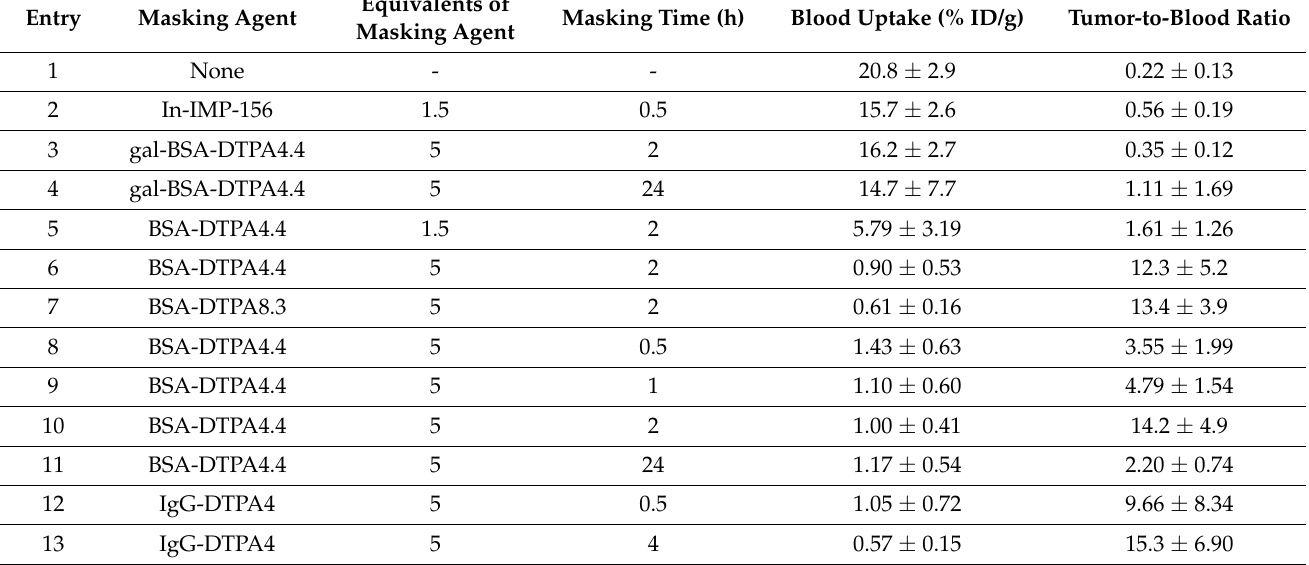
Table 4. Overview of masking agents used in the study of Karacay et al. Nude mice bearing GW-39 tumors were injected with 150 nmol of bsAb MN-14 × c734, and masking agents were injected 65 h later. Equivalents were based on blood levels of 125 I-bsAb at that time point. After the shown masking time, 99m Tc-IMP-192 was injected, and animals were necropsied 3 h